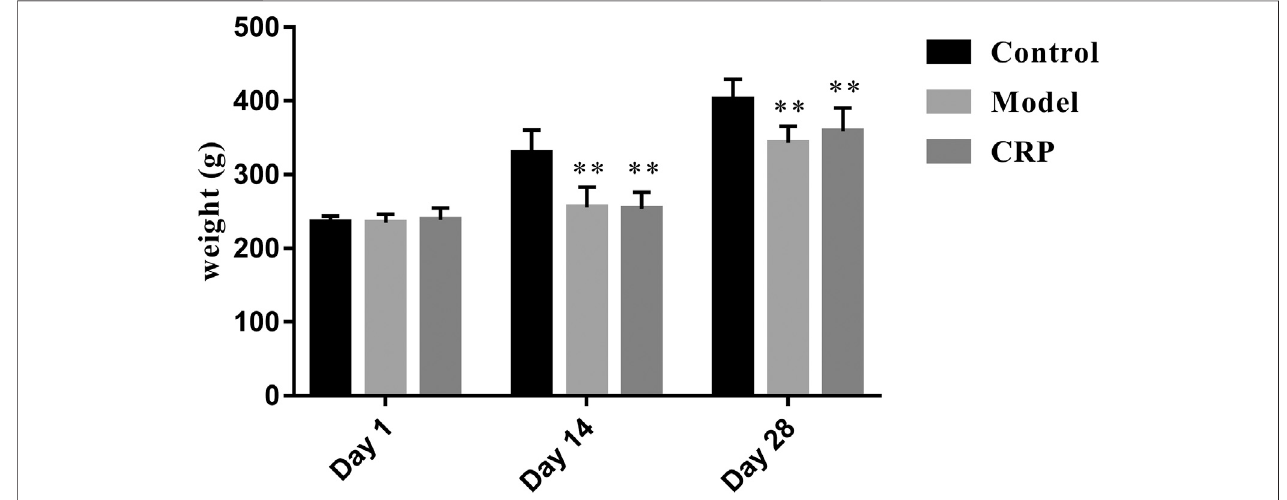
FIGURE 1 | Rat body weights comparison between control, model and CRP treated group. ( n (cid:2) 10, ** p < 0.01, vs. control group. Although the body weights of CRP treated group were higher than that of model group after intervention, there existed no signi fi cant difference.)